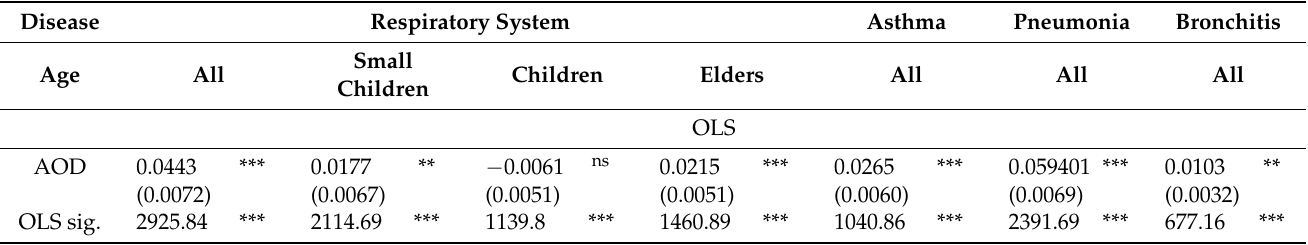
Table 6. Mean effect of the variation in aerosol optical depth (AOD) on hospitalization due to thermal anomalies, presented by age and respiratory illness